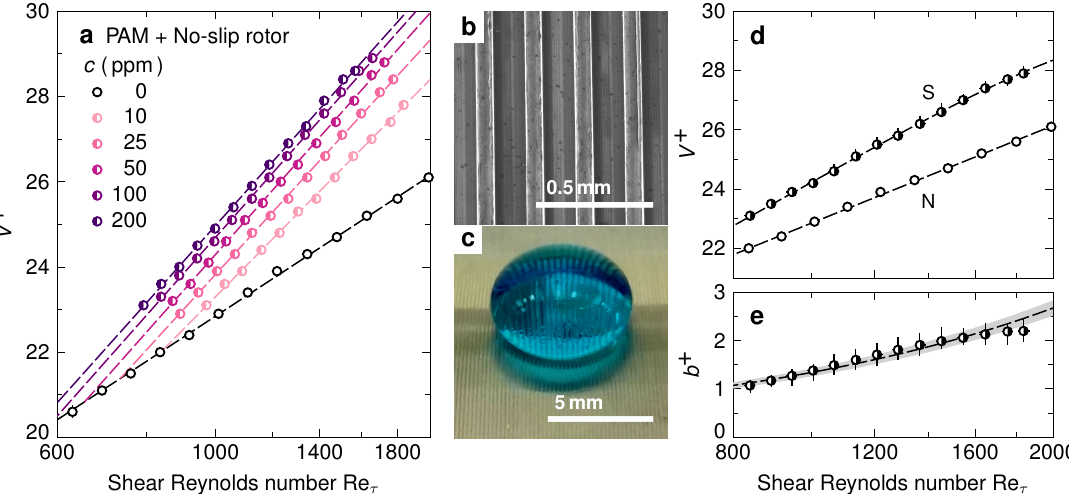
Figure 1. ( a ) Polymeric drag reduction curves for the no-slip rotor in aqueous polyacrylamide (PAM) solutions (concentration labeled in ppm). The hollow circles denote baseline friction in pure water. ( b ) SEM image of the grooved rotor surface. ( c ) Water drop, dyed blue, placed on the grooved rotor. The plastron within the groove troughs appears enlarged due to refraction through the drop. ( d ) Superhydrophobic drag reduction curve ( S ) for the grooved rotor in deionized water; the baseline no-slip data ( N ) from ( a ) is also included for comparison. ( e ) The dimensionless effective slip length b + measured on the grooved rotor. The dashed curve and the gray band denote the expected variation of b + for a constant dimensional slip length of b = ( 17 1 ) µm. Error bars represent the full range of ± observations over 10